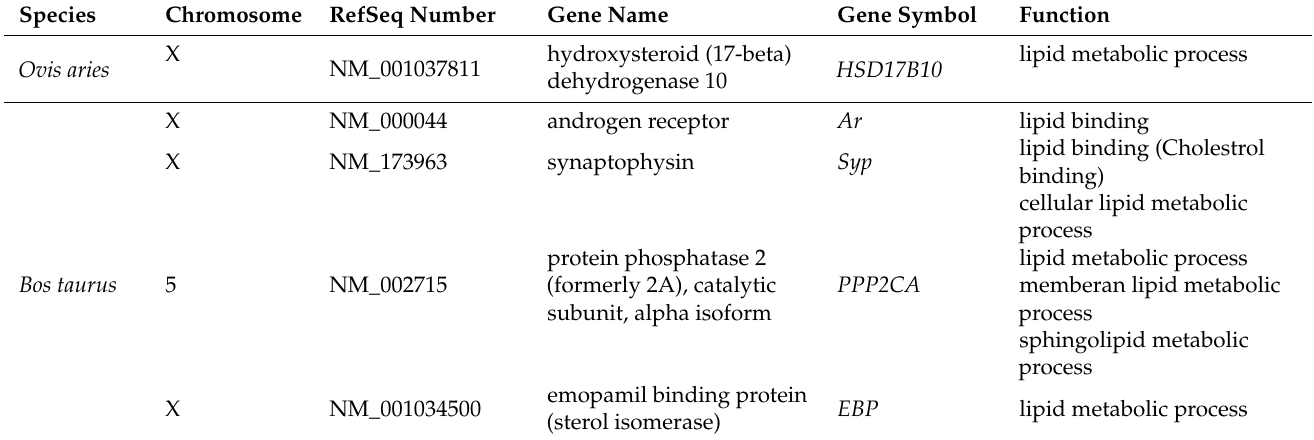
Table 4. Fat metabolism related genes located within the candidate regions in O. aries and their orthologous area in B. taurus .